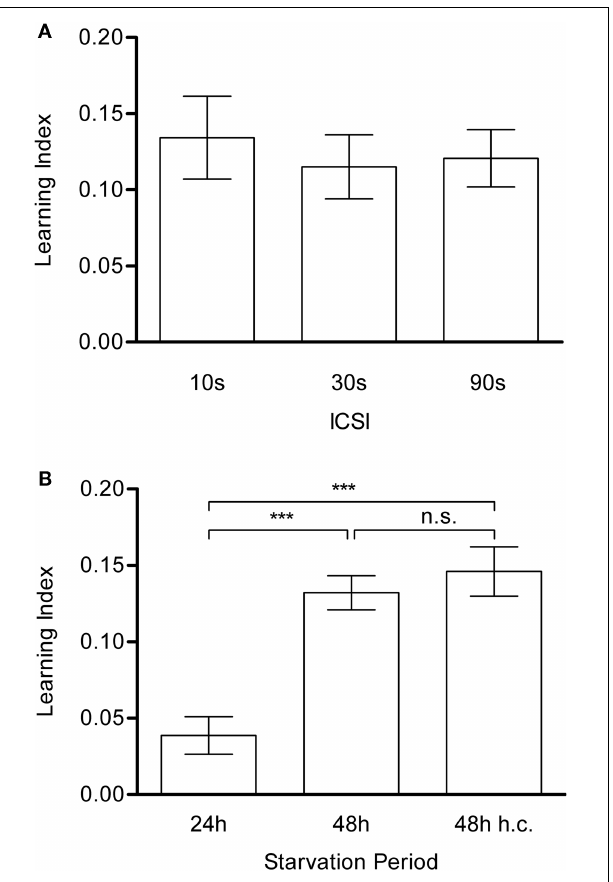
FIGURE 6 | Inter-CS interval and starvation-dependency of visual appetitive memory. (A) The effect of duration of the inter-CS interval (ICSI). The interval lasted 10, 30 or 90 s. All groups showed signifi cant memory [one- sample t -test, 10 s: t = 4.925, P < 0.001; 30 s: t = 5.476, P < 0.001; 90 s: (19) (19) t = 6.394, P < 0.001] while no signifi cant difference could be found among (17) all groups [one-way ANOVA, F = 0.1897, P > 0.05]. n = 18–20. (B) The (2,55) effect of starvation periods. Flies were starved for 24, 48 or 48 h at high humidity conditions (h.c.). All groups showed signifi cant memory [one-sample t -test, 24 h: t = 3.154, P < 0.05; 48 h: t = 11.87, P < 0.001; 48 h h.c.: FIGURE 5 | Appetitive visual associative memory. (A) Time course of the (17) (15) t = 9.022, P < 0.001], while longer starvation resulted in a signifi cantly mean preference for the green stimulus of naïve fl ies (no training) and fl ies that (12) higher performance than short starvation [ t -test, t = 5.288, P < received four training trials [two reciprocal groups: Green + /Blue − (green) and (32) Blue + /Green − (blue). Flies that received a sugar reward with green light showed a higher preference for the green stimulus during the test phase than the reciprocal group having received the same reward with blue light. (B) Time course of the mean LIs of fl ies with (1, 2, 4 or 8) or without (0) training trials. (C) Effect of training repetition. Without training no signifi cant memory could be found [one-sample t -test, t = 1.159, P > 0.05], whereas all trained groups (13) showed signifi cant memory [one-sample t -test, one trial: t = 4.632, P < 0.01; (17)